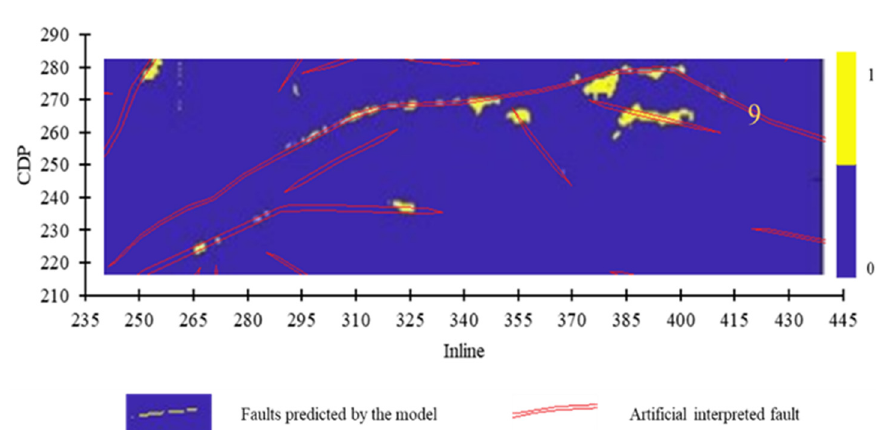
Figure 19. The prediction result of Fault 9 by Region C as training set.